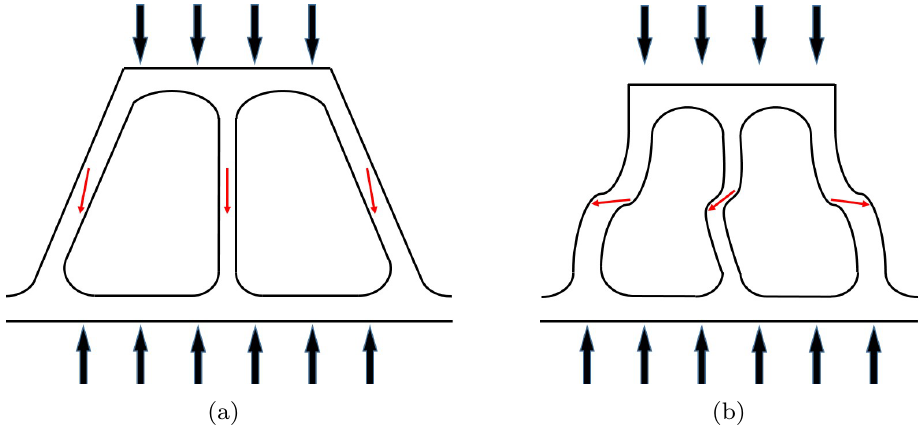
34 Figure 12. Schematic diagrams of struts under compressive loading: ( a ) a initial state and ( b ) a Figure 12: Schematic diagrams of struts under compressive loading: (a) a initial state, and deformed (b) a deformed state